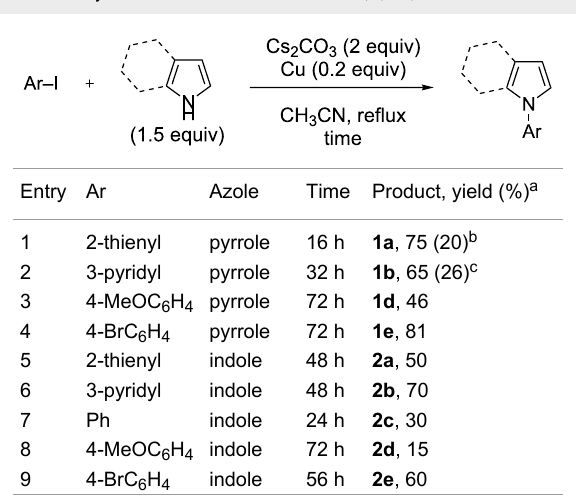
Table 1: Synthesis of the azole substrates 1a , b , 1d , e and 2a–e .